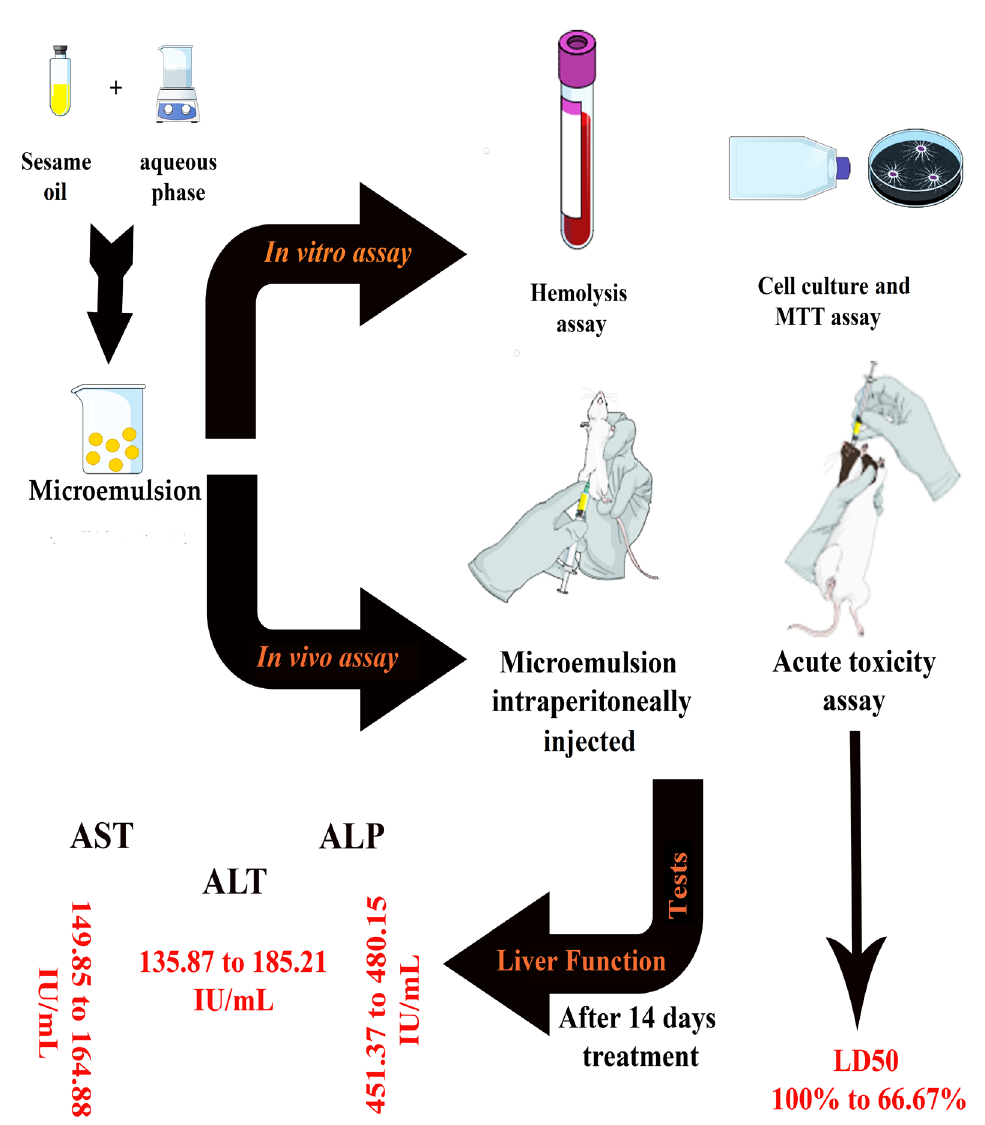
Figure 1. A depiction of the experimental research design and steps during the study.